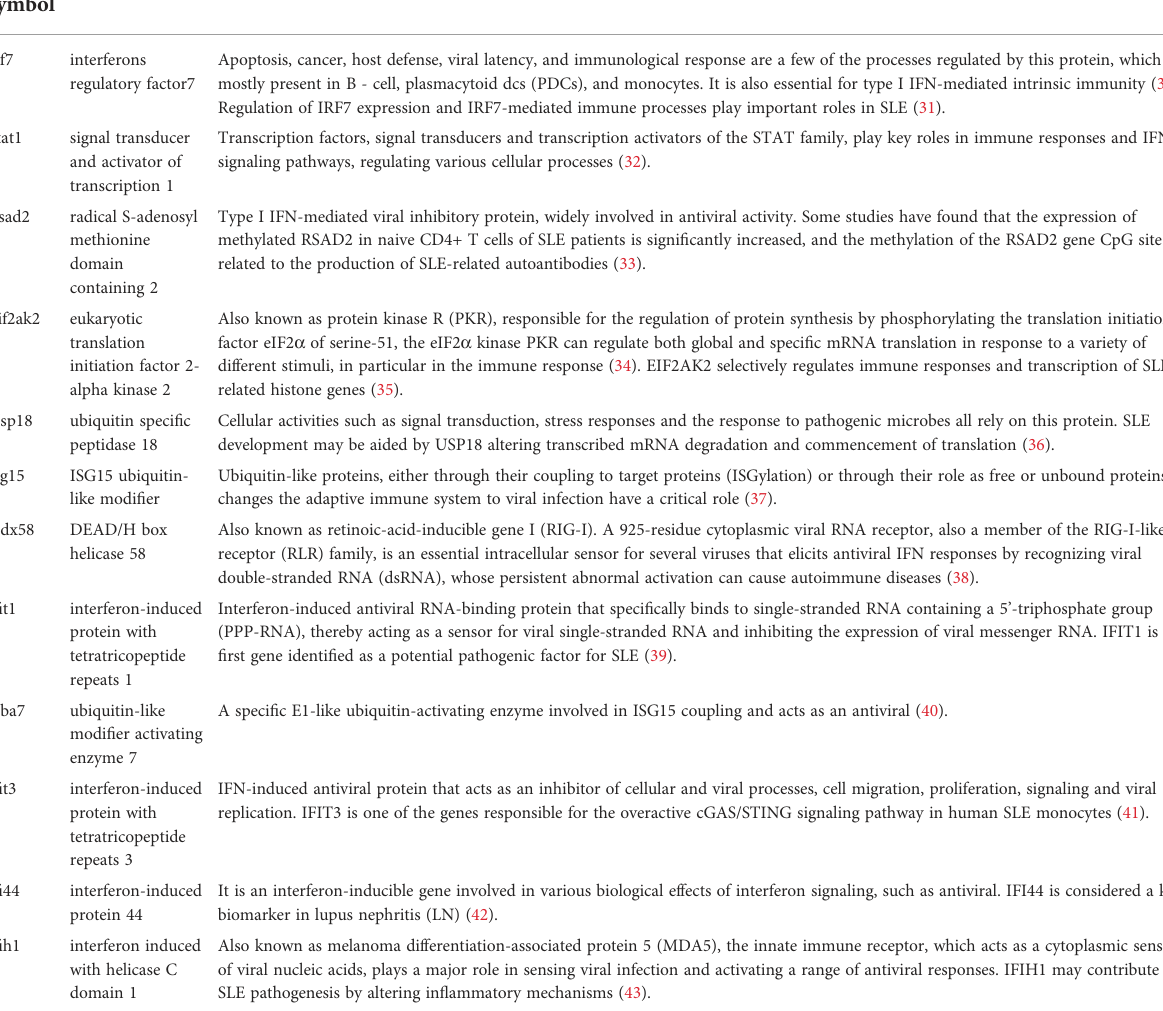
TABLE 4 Key genes with innate immune memory in MRL/lpr